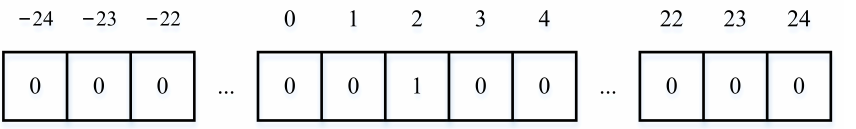
Figure 6. A coding example when IMP is